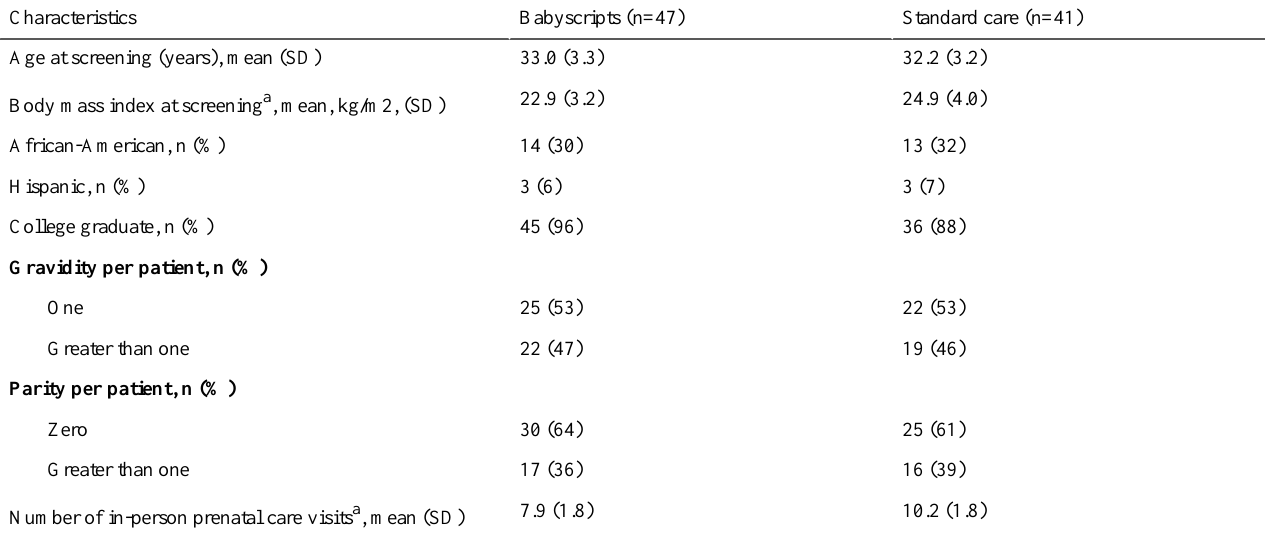
P =.01 Table 2; Figure 2). Patient satisfaction measured